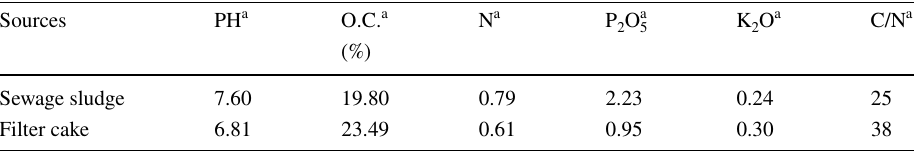
a Evaluations proposed by